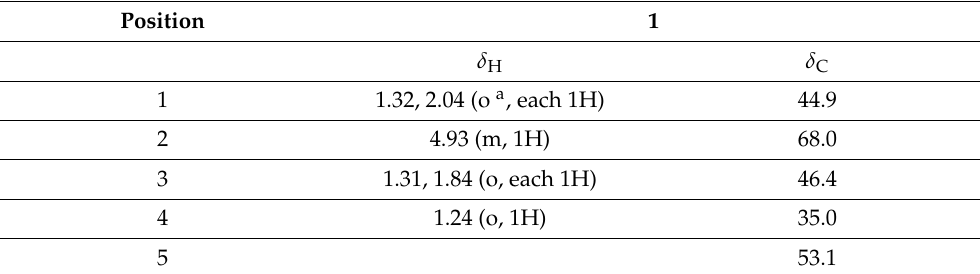
Table 1. 1 H and 13 C NMR spectroscopic data of compound 1